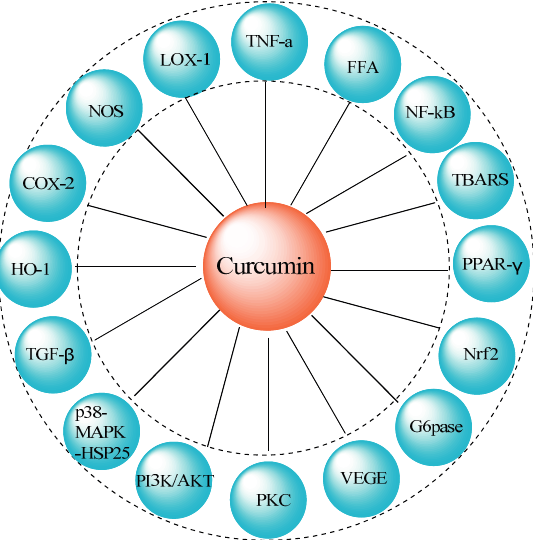
Figure 4. The anti-oxidative and anti-inflammatory molecular targets of diabetes for curcumin